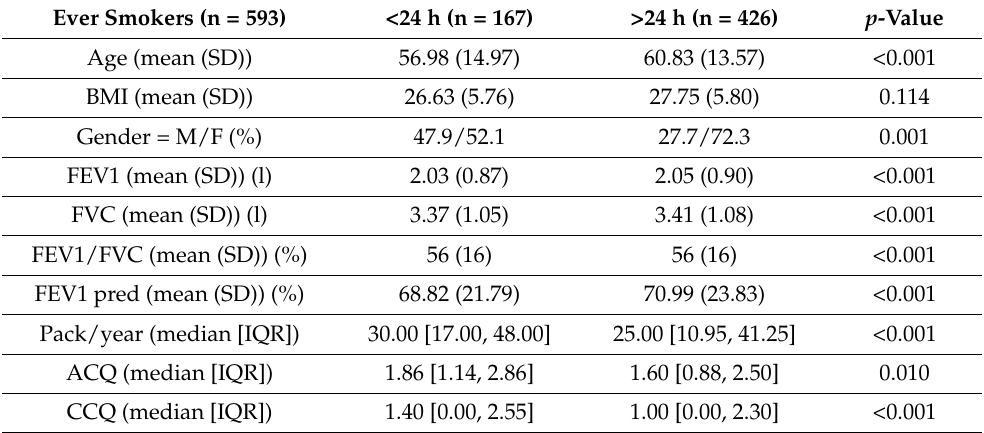
Table 2. Clinical characteristics of patients with recent cigarette consumption. Data are expressed in number of patients, mean ± standard deviation or median and range for non-normal distributions.